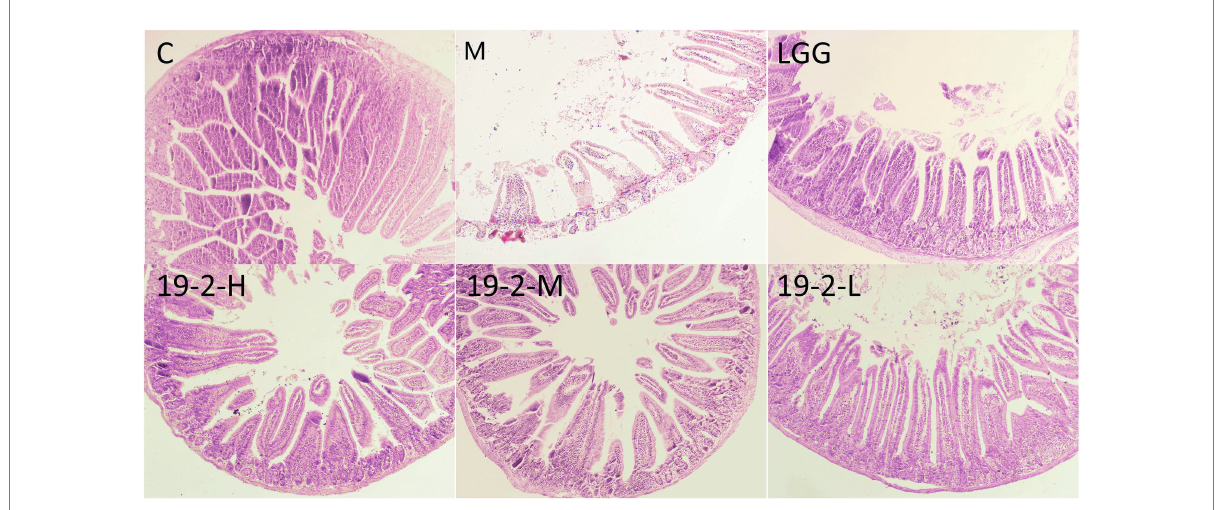
FIGURE 7 Section of jejunum under light microscope at 400